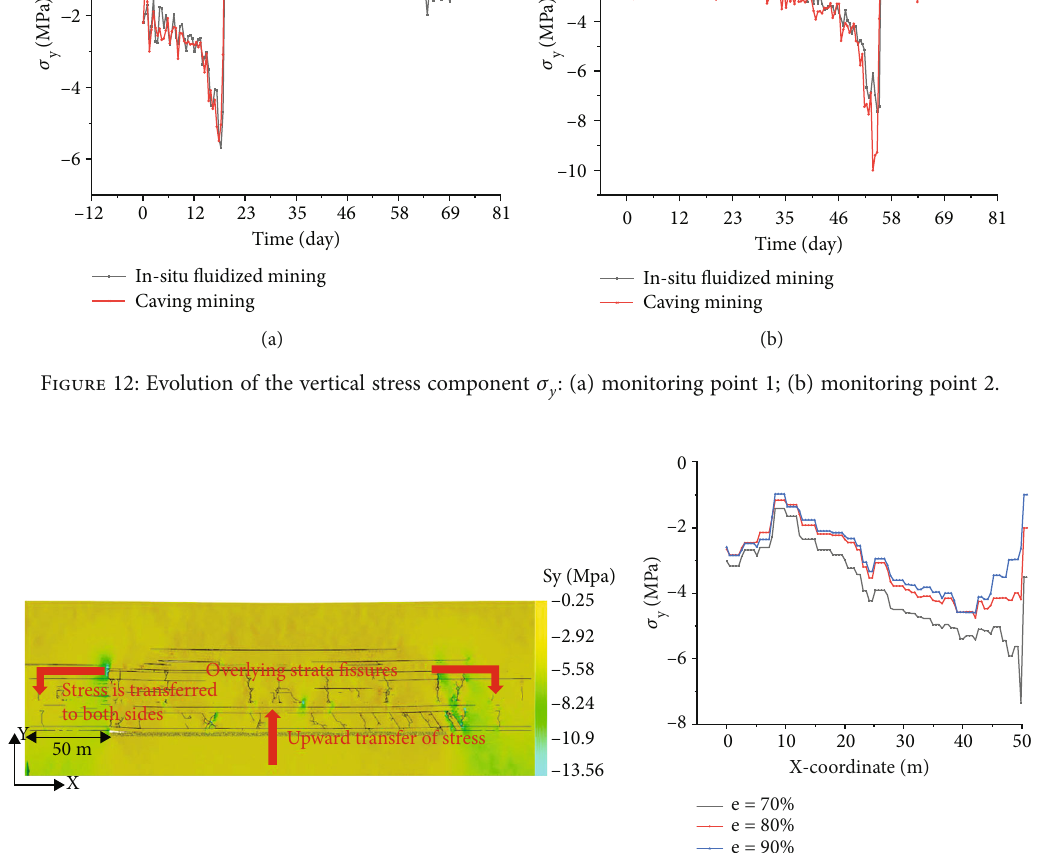
fi lling ratio of 90%; (b) the y considering a